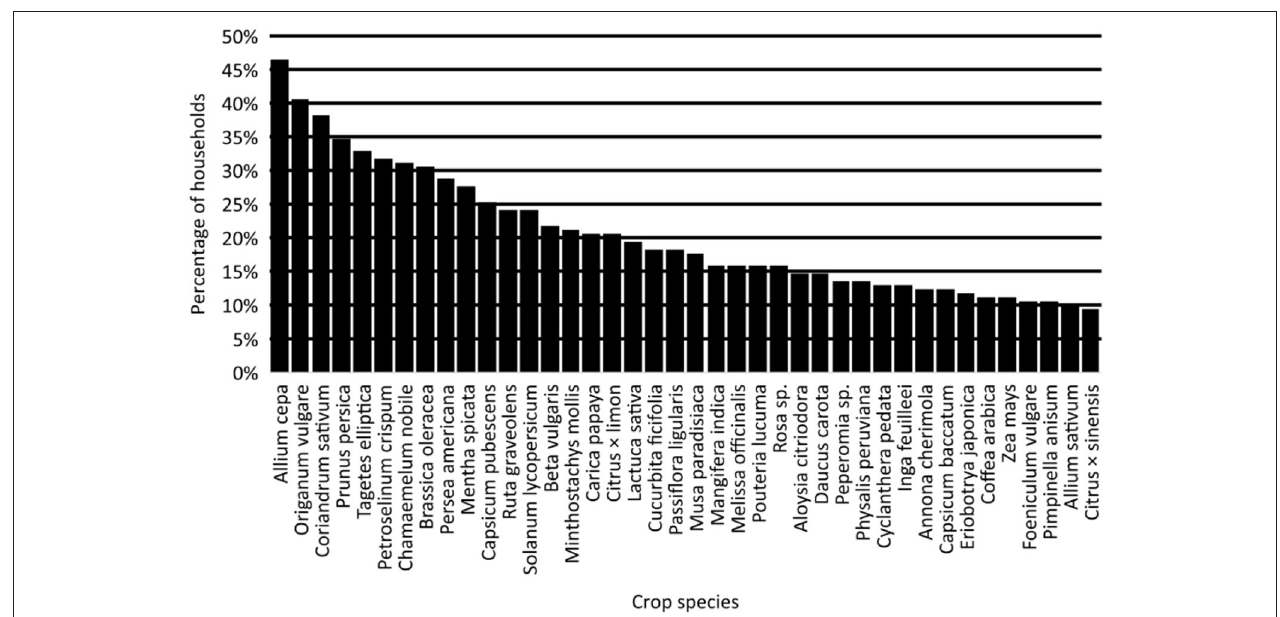
FIGURE 4 | Frequency of agriculturally managed species in home gardens of households ( n